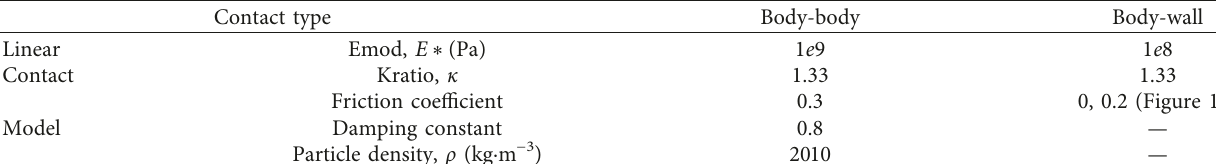
Table 2: Contact attribute parameters of the numerical model.